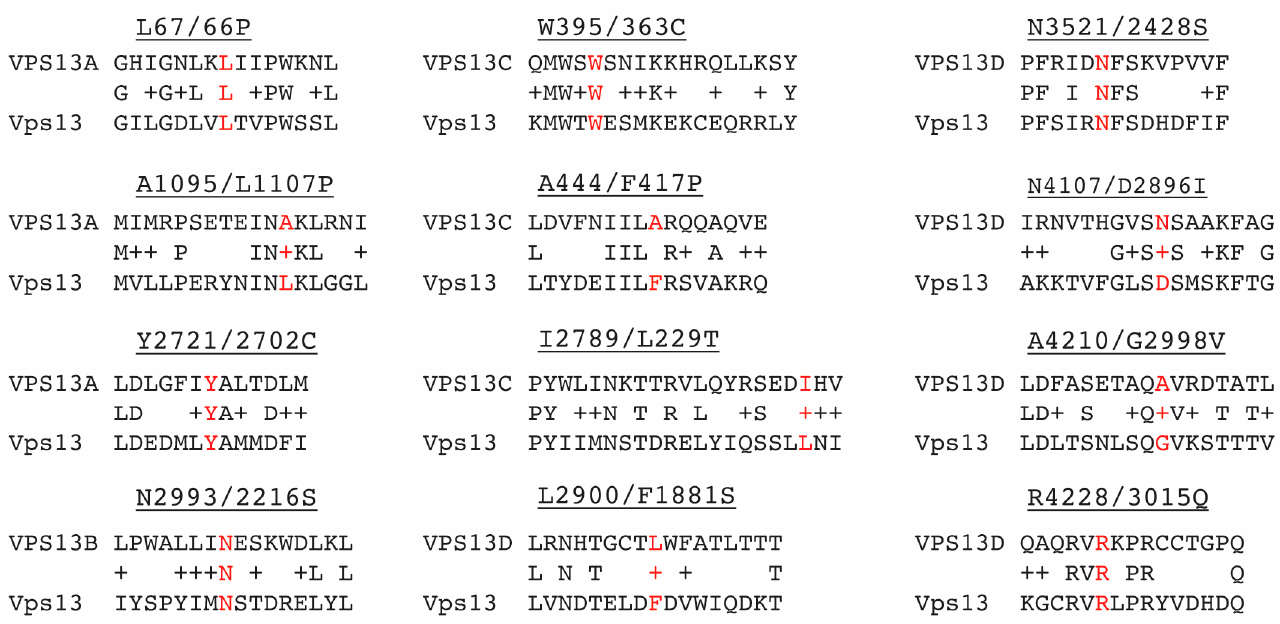
Figure 1. Alignments of regions of different human VPS13 paralogs and yeast Vps13. Labels have the format “Mammalian amino acid and position/yeast cognate amino acid and position, ending with the amino acid in the mammalian gene mutant”. The cognate amino acids are highlighted in red. All the alignments were produced by BLAST search except for the regions around VPS13B N2993 and VPS13D L2900, which were based on the VAB repeat sequences defined in [21].